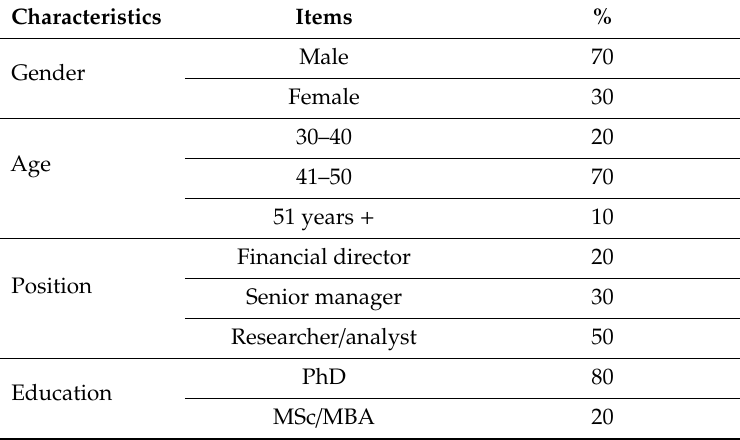
Table 2. Characteristics of panel of